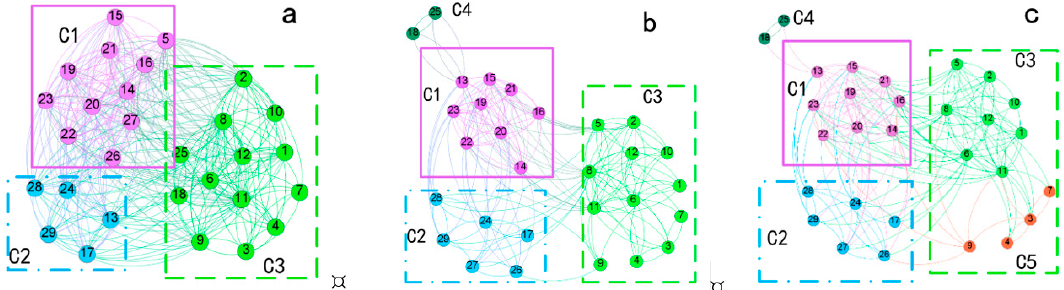
Figure 16. Topology views with areas selected ( a ) layer1, ( b ) layer2, and ( c ) layer3: The corresponding three areas are area1 (purple), area2 (blue), and area3 (green).